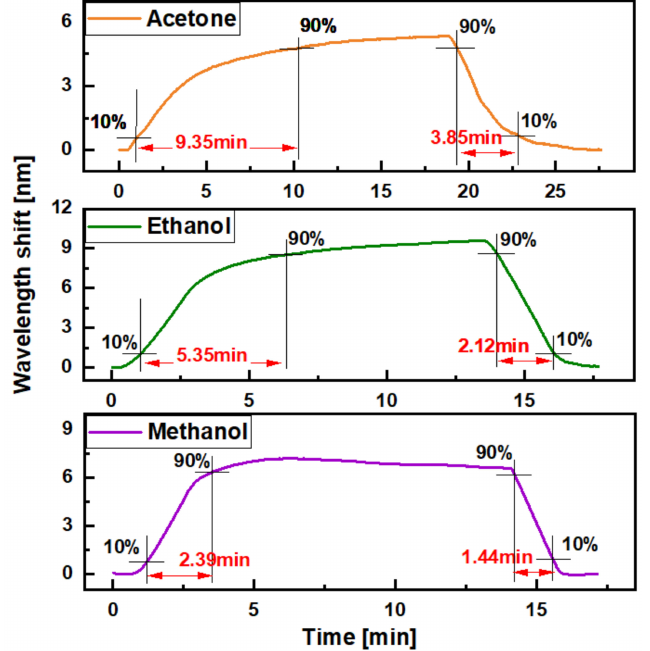
Figure 10. Response and recovery times of OFS for measurement of acetone ( top ), ethanol ( middle ) and methanol ( bottom